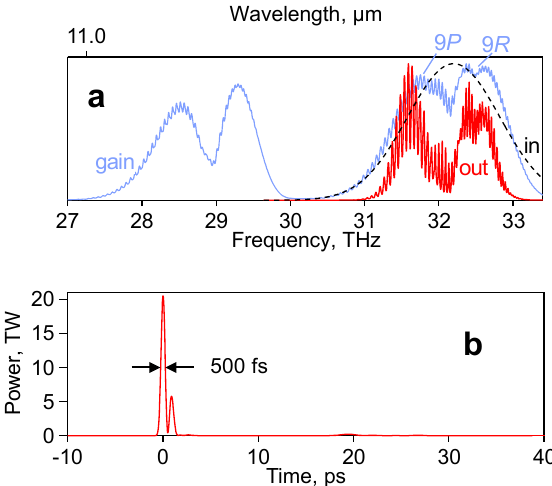
Fig. 3. Calculated spectrum (a, "out") and temporal pulse structure (b) of a 14 J pulse (20 J before compressor) with a 10 mJ, 300 fs pulse seeded into the final amplifier of the ATF’s laser system. The spectrum of the seed pulse and a typical gain spectrum of a high-pressure mixed-isotope CO 2 amplifier are also shown in (a) as "in" and "gain," respectively.